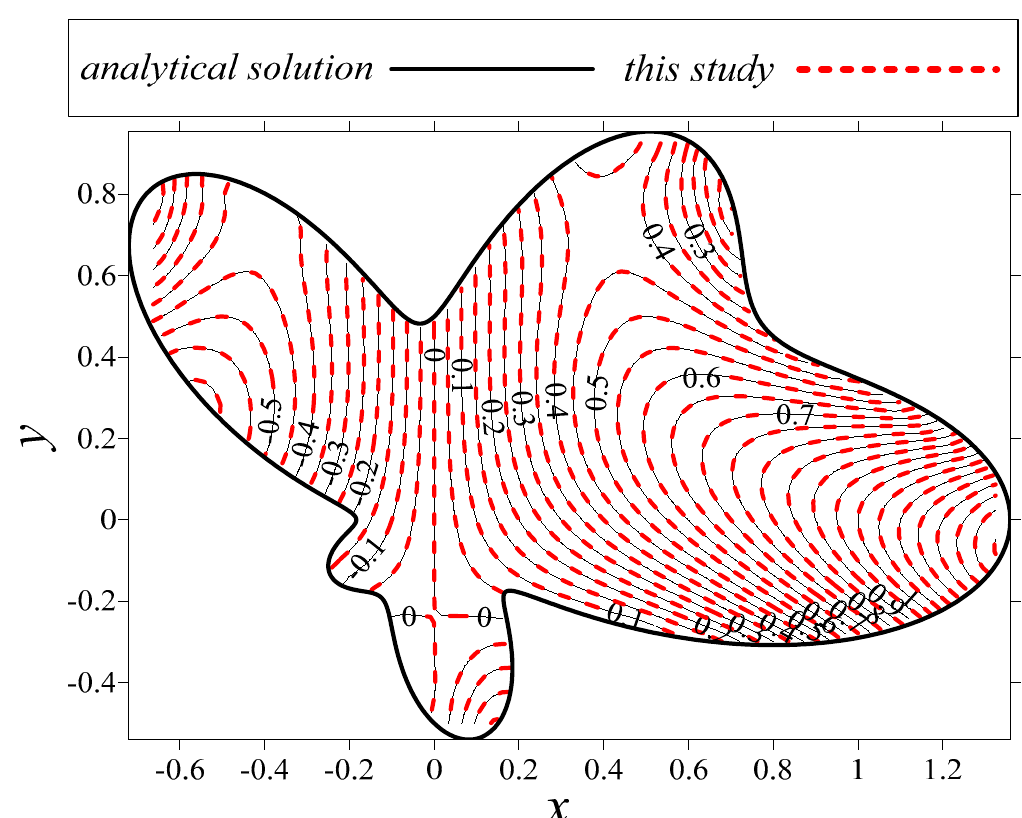
Mathematics 2020 , 8 , x FOR PEER REVIEW Figure 18. The number of inner points versus the maximum absolute error. Figure 18. The number of inner points versus the maximum absolute error.